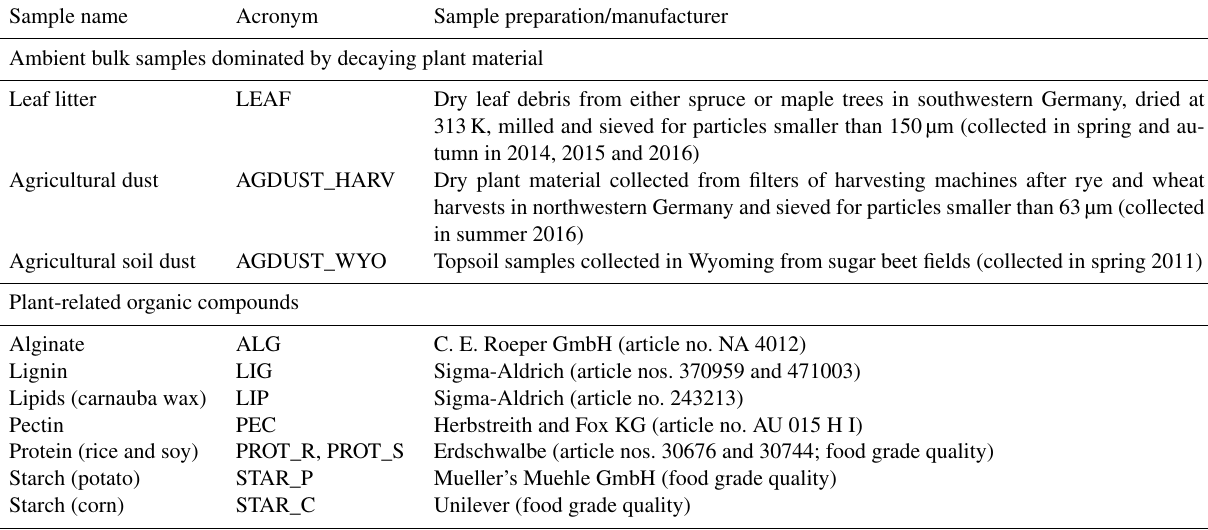
Table 1. Overview of samples used for ice nucleation